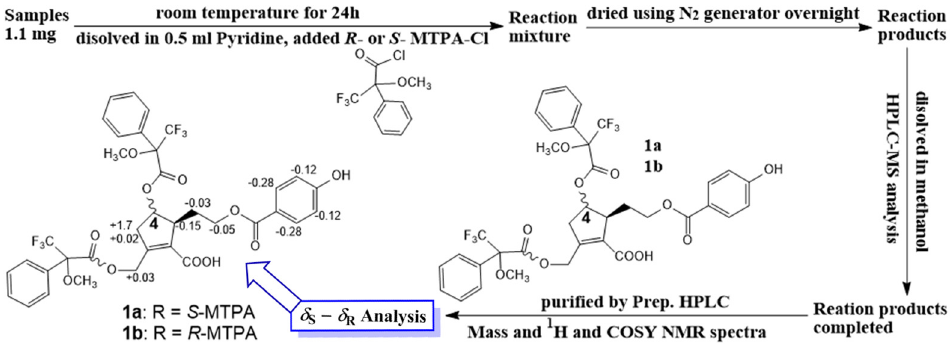
Figure 3. Modi fi ed Mosher’s method. Figure 3. Modified Mosher’s Table 1. Spectroscopic data of compound 1 .